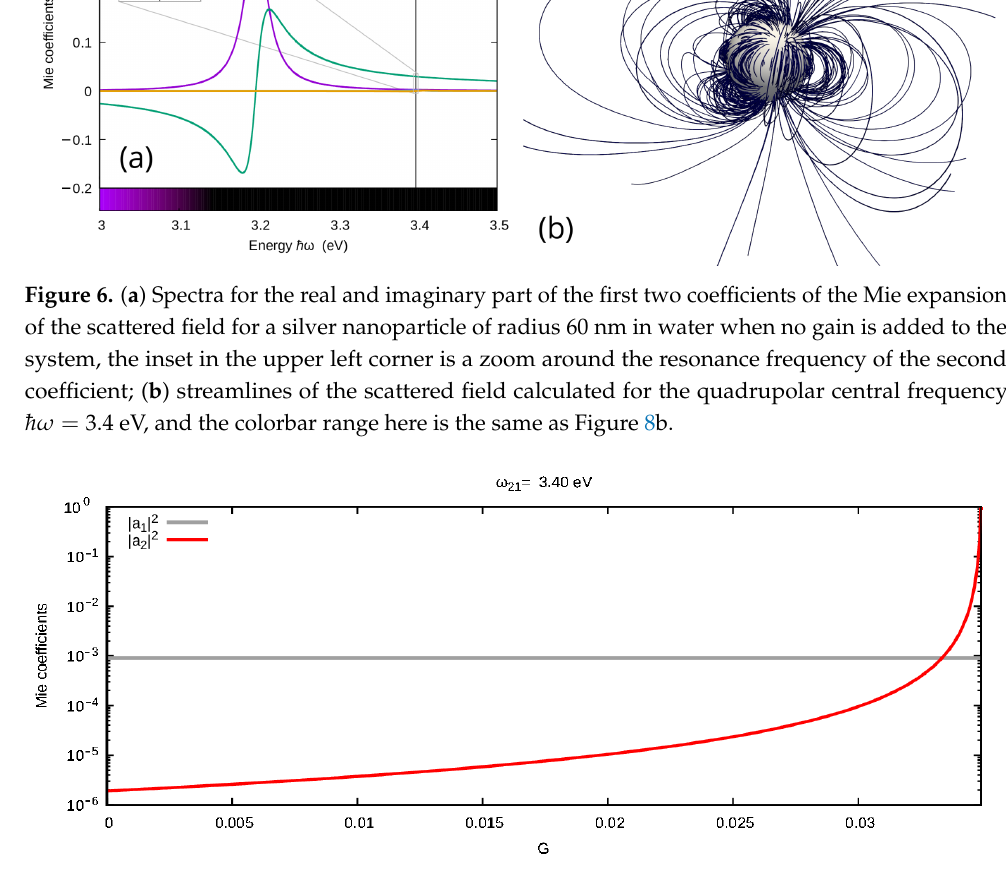
Figure 7. Behavior of the square modulus of the first two coefficients of the Mie expansion for the scattered field at the quadrupolar mode frequency; calculated for a silver nanoparticle of radius 60 nm in water as a function of the gain quantity G present in the system. Here, the emission central frequency was chosen to correspond to the resonance frequency of the quadrupolar